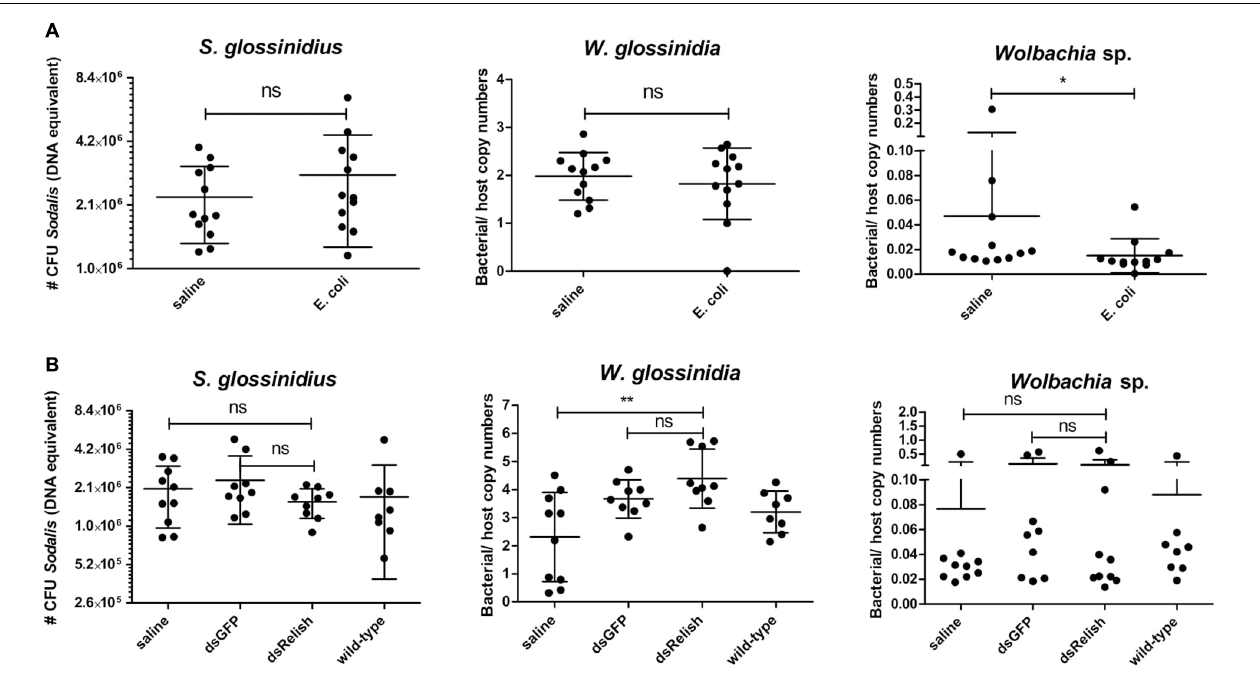
FIGURE 8 | (A) Sodalis glossinidius , Wigglesworthia glossinidia, and Wolbachia sp. densities in tsetse flies with an activated immune deficiency (Imd)-pathway, derived by exposing flies on day 8 post-eclosion to 10 5 CFU E. coli via intrathoracic microinjection as well as per os and evaluated in the abdomen after 48 h, as well as their corresponding injection-control with sterile saline. (B) S. glossinidius , W. glossinidia, and Wolbachia sp. densities in the tsetse flies with an impaired Imd-pathway, derived 7 days after subjecting flies to a dsRelish-treatment, their corresponding controls with dsGFP and sterile saline, and untreated, age-matched wild-type counterparts. The RNA interference (RNAi)-experiment was performed in duplicate and the results are shown from one experiment. The S. glossinidius density was determined using a standard curve-based S. glossinidius -specific qPCR assay. The W. glossinidia and Wolbachia sp. densities were defined as the bacterial genome copy number over the tsetse host genome copy number ( α -tubulin ) and obtained using species-specific qPCR assays. Values show the bacterial density in each abdomen and are represented as the mean with the standard deviation. N = 10 independent replicates per groups and N = 8 independent wild-type flies. The number S. glossinidius CFU is represented in log-scale on the y-axis. ∗ p -value < 0.05; ∗∗ p -value < 0.01; ns, not